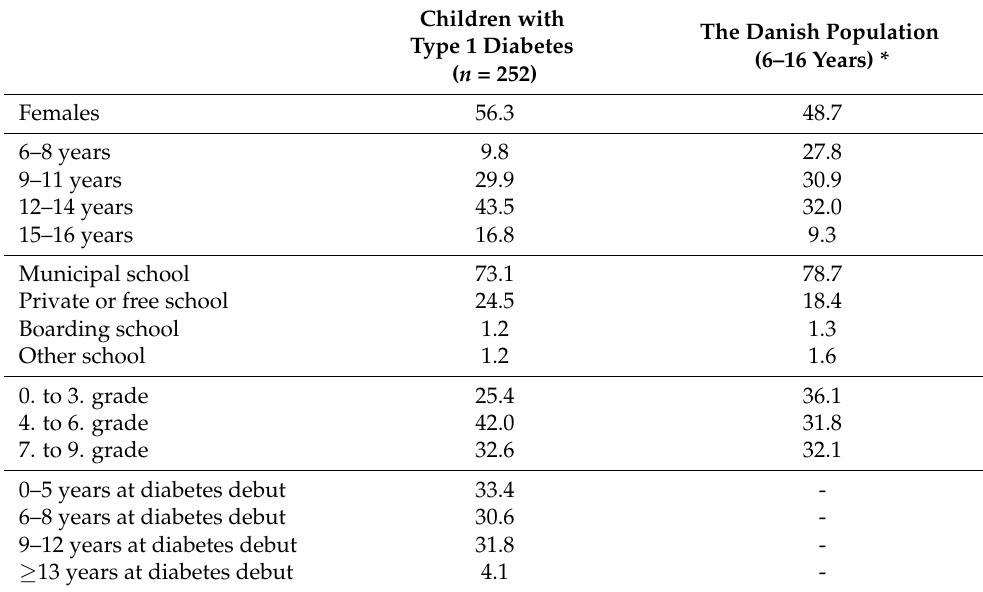
Table 2. Characteristics of the schoolchildren with type 1 diabetes and the background population (the Danish population 6–16 years in 0. to9. grade). Characteristics are presented in frequencies (%). Children